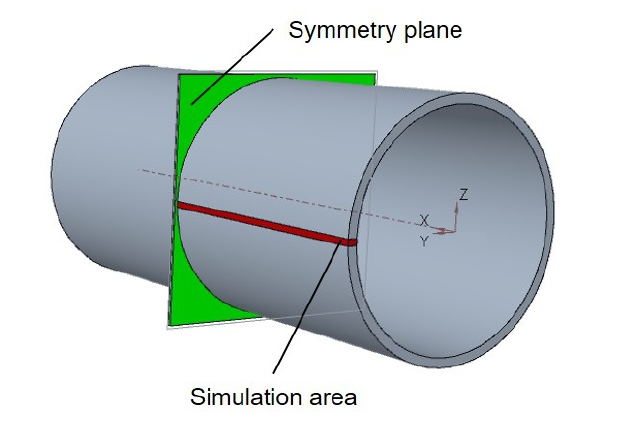
Figure 3. Simplified simulation with symmetry plane and rotation axis.